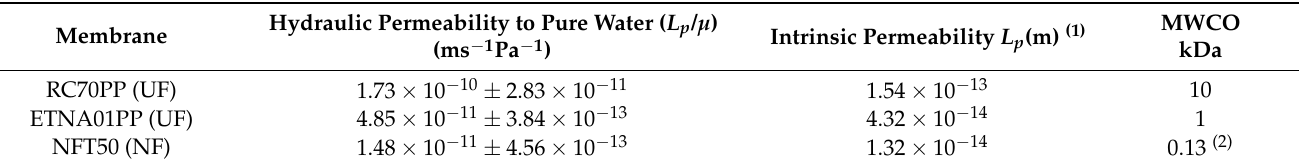
Hydraulic permeability of membranes ( ± 95% confidence interval), intrinsic permeability and MWCO of membranes. Hydraulic Permeability to Pure Water ( L p / µ Membrane